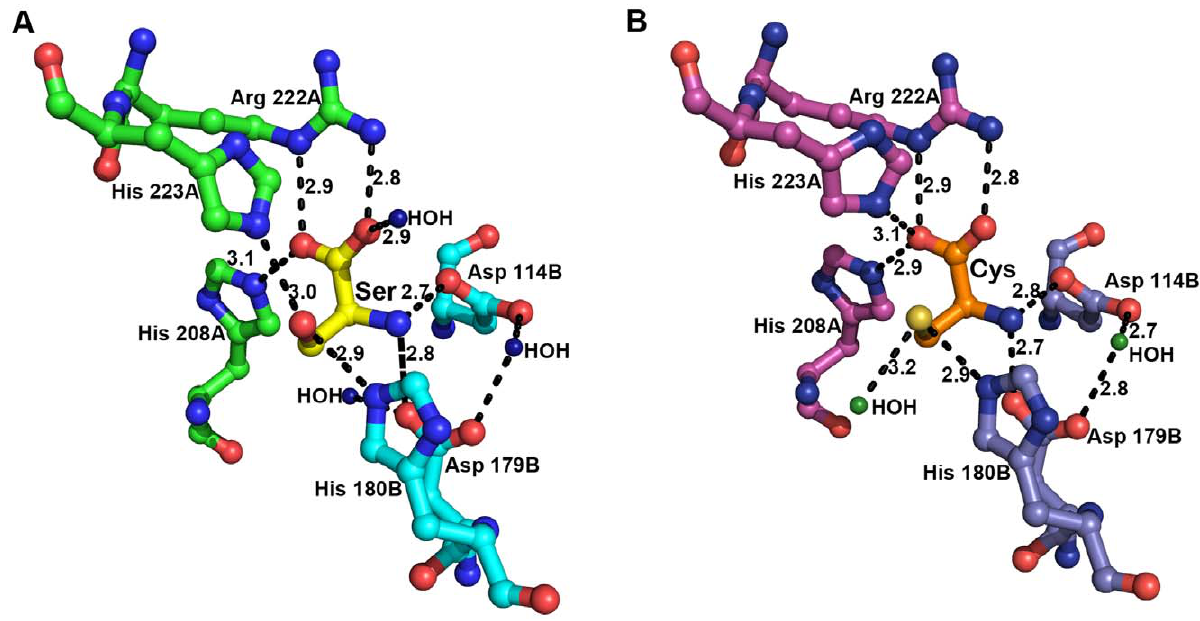
Figure 2. Active site interactions of EhSAT1. Image showing interaction of A) L-ser and B) L-Cys with the active site residues of EhSAT1 as visualized in crystal structure of EhSAT1-ser (PDB id 3Q1X) and EhSAT1-cys (PDB id 3P47) [8]. A) A salt bridge is formed in between the carboxyl group of Ser and the side chain of Arg 222A. This carboxyl group also makes a hydrogen bond with side chain of His 208A and a water molecule. Side chains of His 223A and His 180B make other hydrogen bonds with the hydroxyl group of the serine. The amino group of serine forms a salt bridge with the carboxyl group of the Asp 114B and Asp 179B. B) Interactions with the inhibitor L-cysteine bound at active site of EhSAT1. Cysteine coordinates with the same residues as that of serine, but with minor repositioning. The carboxyl oxygen interacts with the amide group of the Arg 222A and also with His 223A and His 208A. The thiol group interacts with His 180B, His 223A, and a water molecule. The amine of cysteine bonds with the carboxyl groups of the Asp 114B and Asp 179B. The image was prepared using Pymol